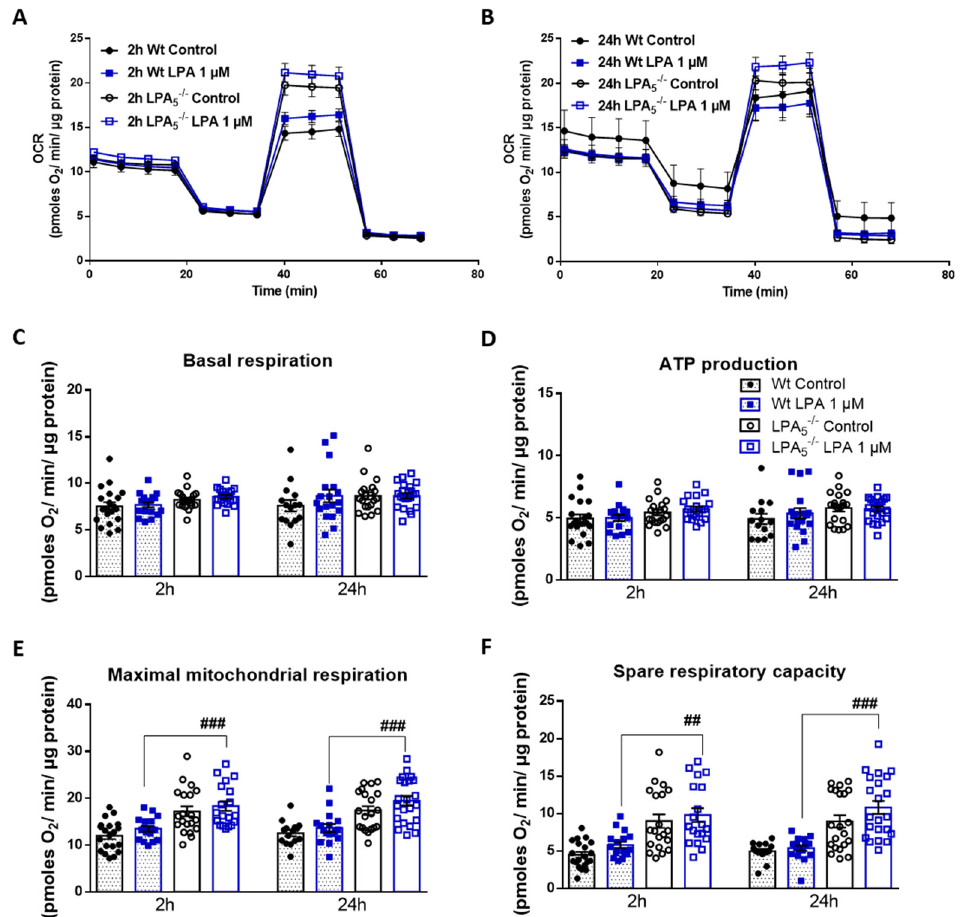
Figure 5. LPA 5 regulates mitochondrial respiration in primary microglia. ( A , B ) Oxygen consumption rate (OCR) in the absence and presence of LPA (1 µ M) for 2 or 24 h was measured using the XF Cell Mito Stress Test. Primary microglia isolated from wt and LPA5 -/- mice were treated with 2 µ M oligomycin, 1.75 µ M FCCP, and 2.5 µ M antimycin A in XF assay medium to assess mitochondrial function parameters. Bar graphs show ( C ) basal mitochondrial respiration, ( D ) maximal mitochondrial respiration, ( E ) ATP linked respiration, and ( F ) spare respiratory capacity. Values are expressed as mean ± SEM of three independent experiments. ## p < 0.01, ### p < 0.001 LPA 5-/- compared to wt cells; two-way ANOVA with Bonferroni correction.